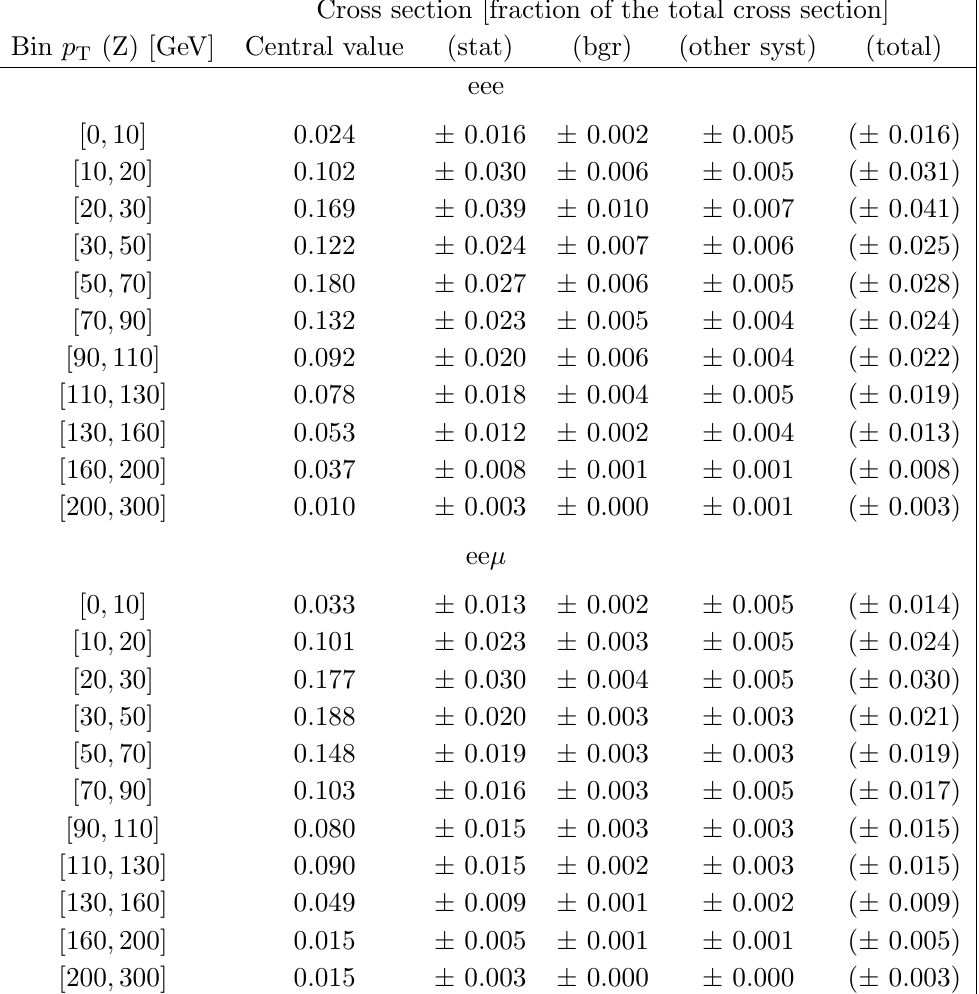
Table 7 . Di(cid:11)erential cross section in bins of p T (Z). Values are expressed as a fraction of the total cross section. The eee and ee (cid:22) (cid:12)nal states are